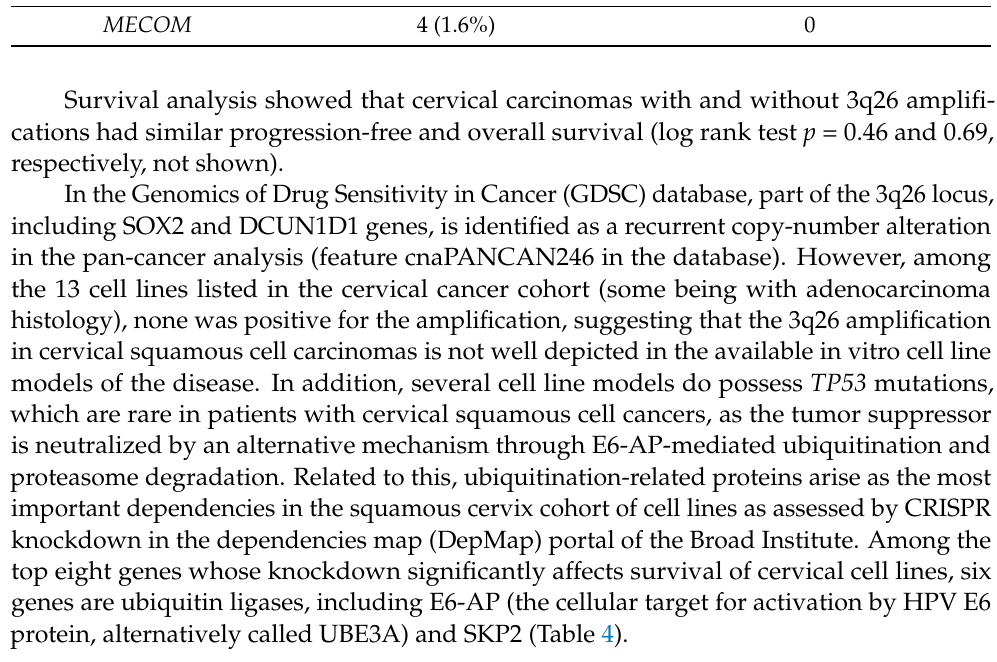
Table 4. Top 8 gene dependencies enriched in cervical squamous context in DepMap. * denotes that the gene was also significant in the CRISPR (Avana) Public 21Q1 dataset, albeit with a higher p -value. Data are from DepMap portal.